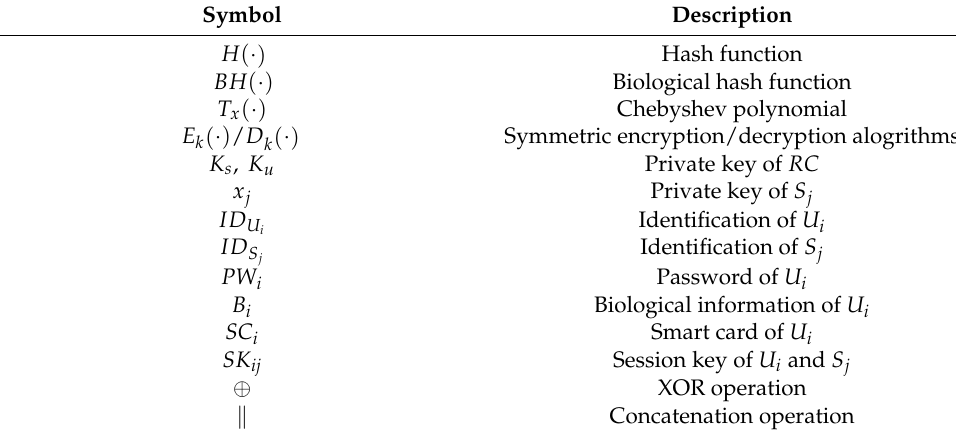
Table 2. Notations in Chatterjee et al.’s